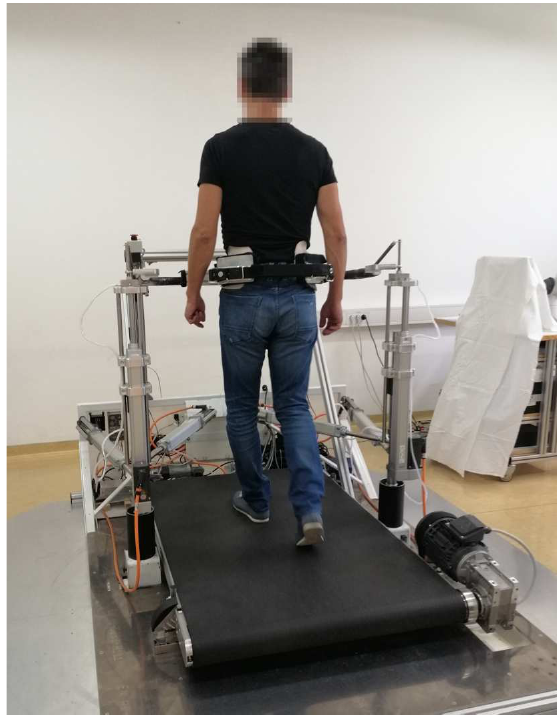
Figure 1. A healthy individual walking on an instrumented treadmill while being embraced by the Balance Assessment Robot for Treadmill walking - BART, which enables perturbations to the subject’s